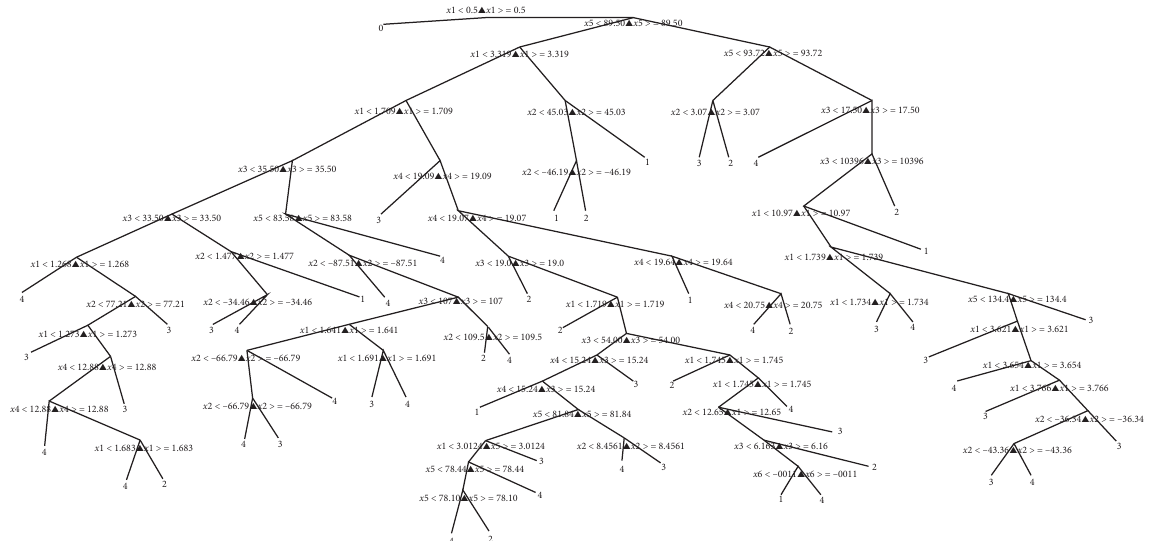
Figure 7: Structure of the decision tree.